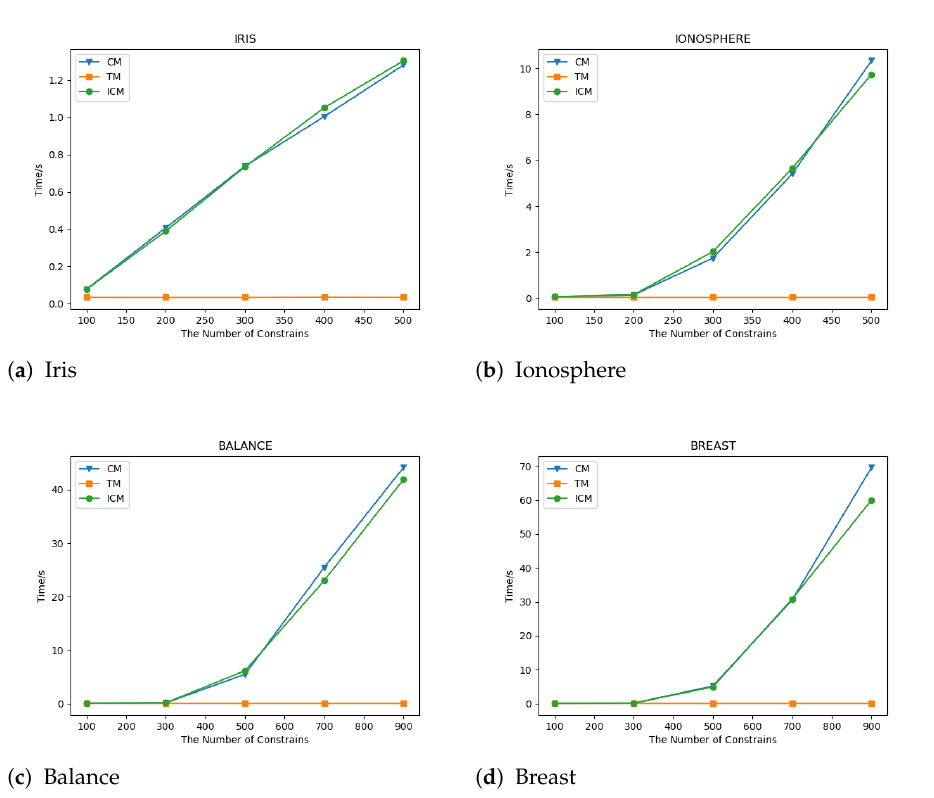
Figure 5. Runtime comparison of CM, TM and